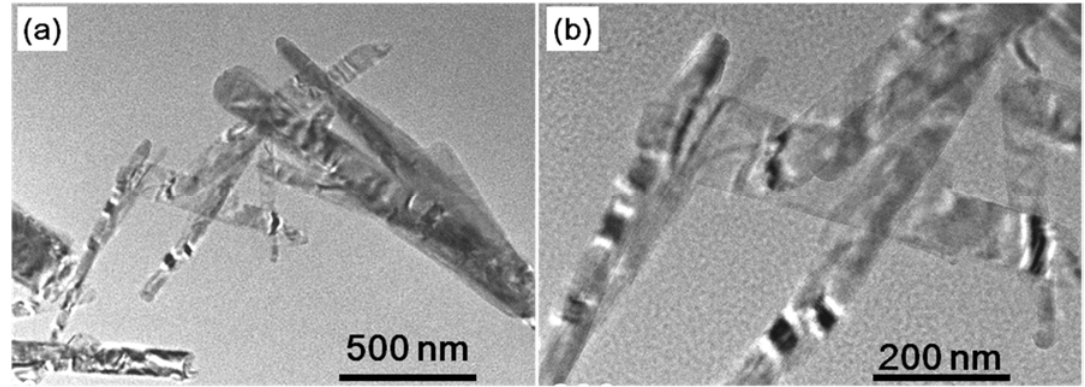
Figure 3. TEM images of the VO 2 (B) nanobelts at different scales: (a) 500 nm; (b) 200 nm.